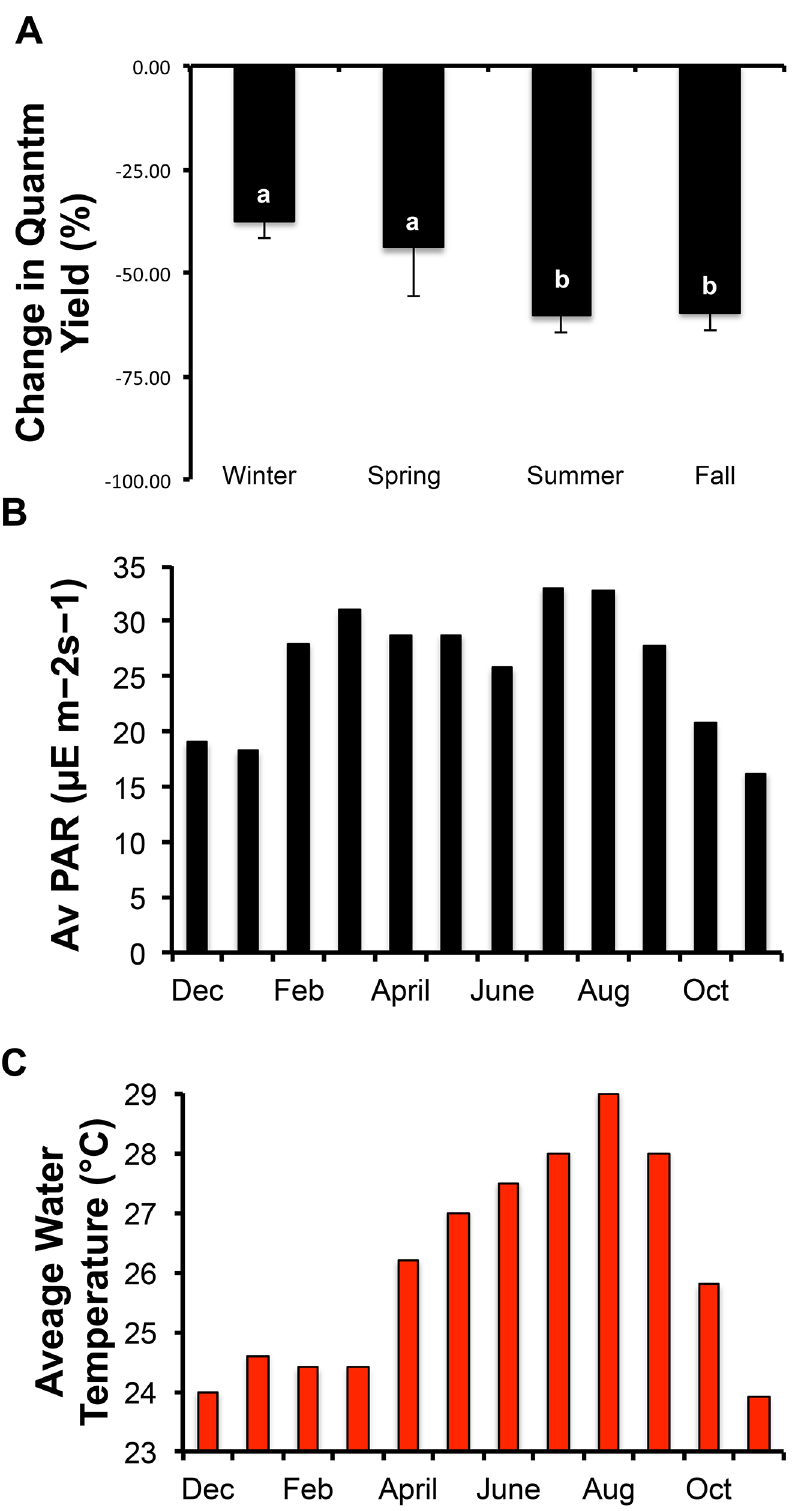
Fig 3. Symbiodinium and seasonal vitrification success. A) Winter and spring were optimal times for vitrification. Bars with differing superscripts were different (P < 0.05); B) A seasonal measure of PAR on Coconut Island, where winter months had the lowest light values (data from [44]); C) Seasonal temperature values on Coconut Island in 2014 where parts of fall and winter months had the lowest ambient temperatures.